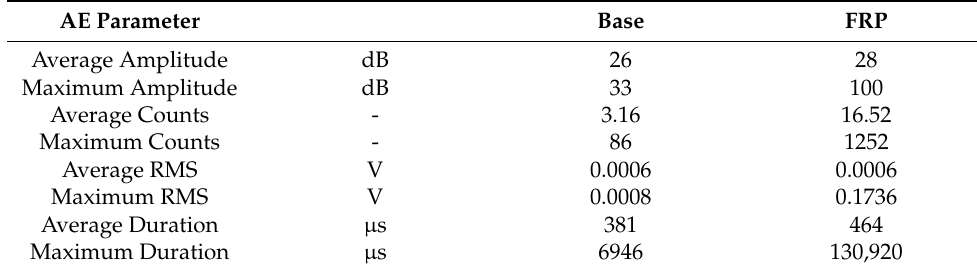
Table 3. Summary of the obtained results.